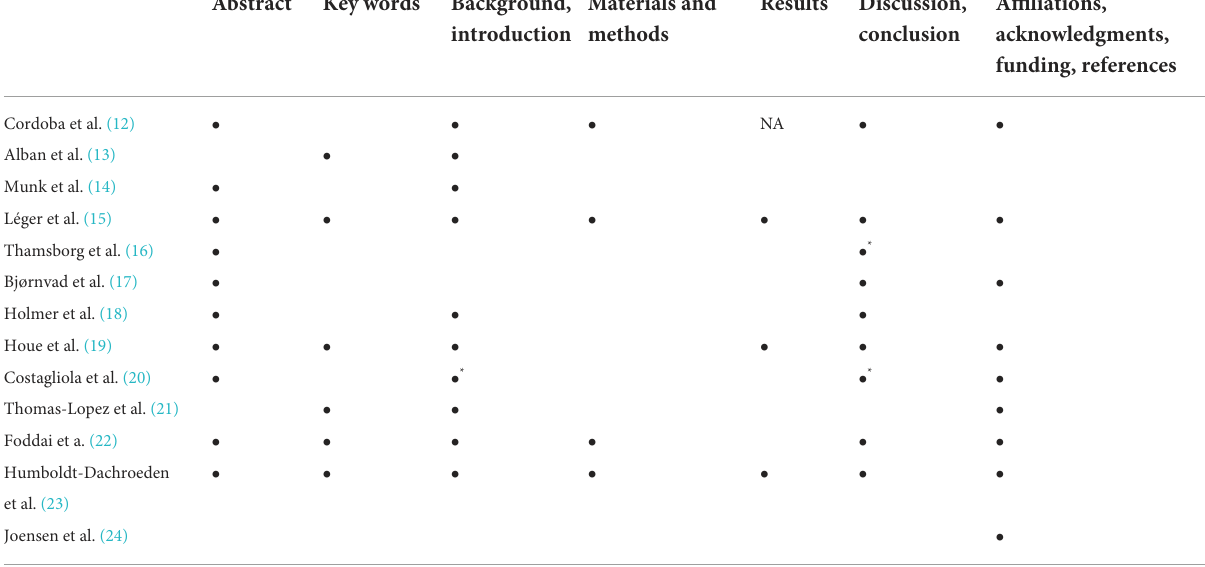
TABLE 1 Section of the publication where One Health was mentioned, among publications included in the